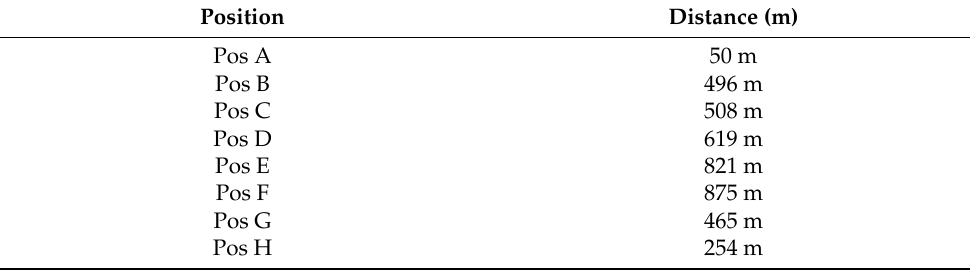
Table 2. Node positions and distance (approximate in a straight line) from the